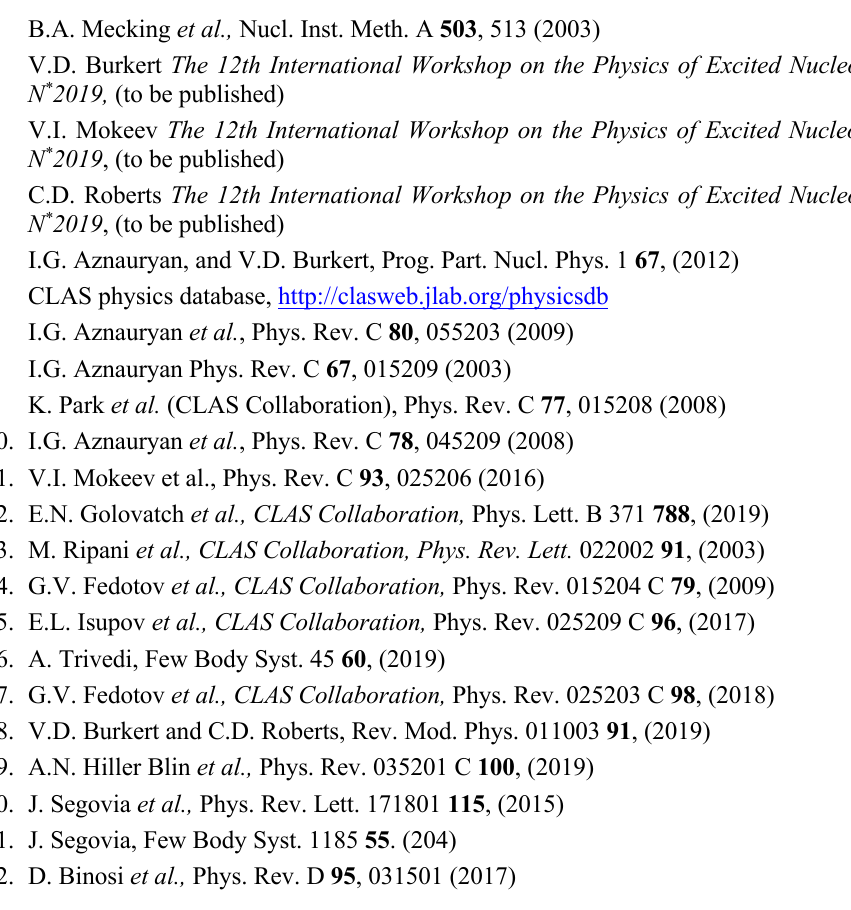
Fig. 6. (Color online) Electromagnetic transition form factors A 1/2 , A 3/2 and S 1/2 of N(1520)3/2 -